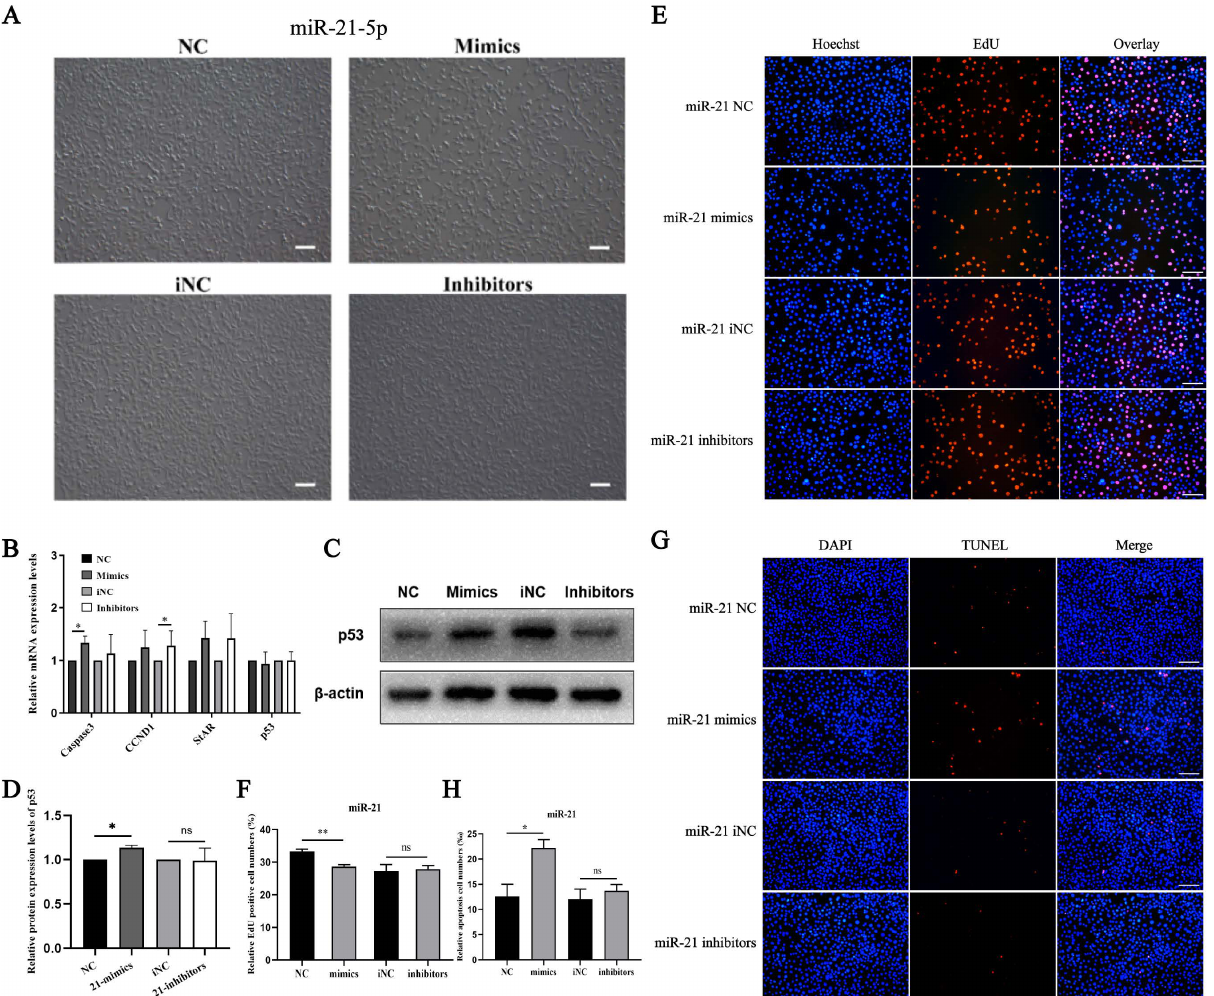
Figure 2. The effects of miR-21-5p on proliferation and apoptosis in TM3 cells. ( A ) The phenotypes of TM3 cells after over-expressing or inhibiting miR-21-5p; ( B ) Expression levels of several genes related to proliferation (CCND1), apoptosis (Caspase3, p53) and steroid synthesis (StAR) after miR-21-5p treatment for 48 h; ( C , D ) p53 protein expression level after overexpression or knockdown miR-21-5p in TM3 cells; ( E , F ) EdU assay was performed after miR-21-5p transfection for 48 h; ( G , H ) TUNEL assay was performed after miR-21-5p transfection for 48 h. Bar value is 100 µ m. * Means p < 0.05, ** means p < 0.01, and ns means no significant